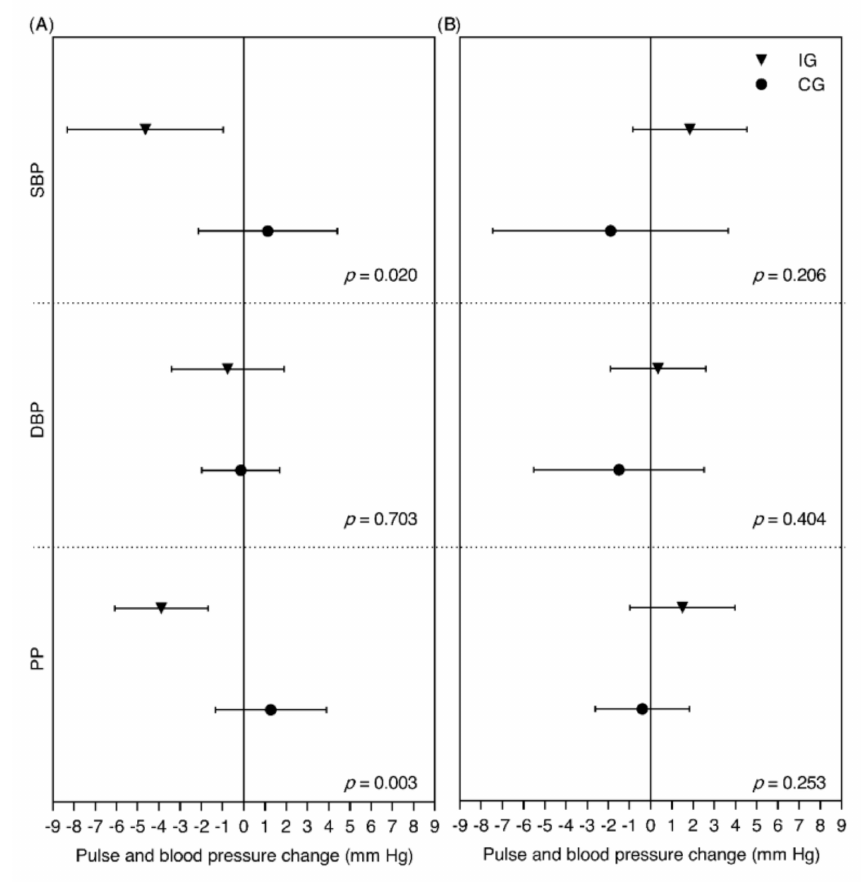
Figure 3. Subanalysis of changes in diastolic blood pressure (DBP), systolic blood pressure (SBP), and pulse pressure (PP) by overweight or obesity as a baseline condition in postmenopausal women participants. ( A ) Subgroup with overweight / obesity (intervention group (IG): n = 39; control group (CG): n = 38). ( B ) Subgroup without overweight / obesity (IG: n = 31; CG: n = 28). Values are di ff erences in means (95% CI). p -values from Student’s t -test for di ff erences in DBP, SBP, and PP between IG and CG are